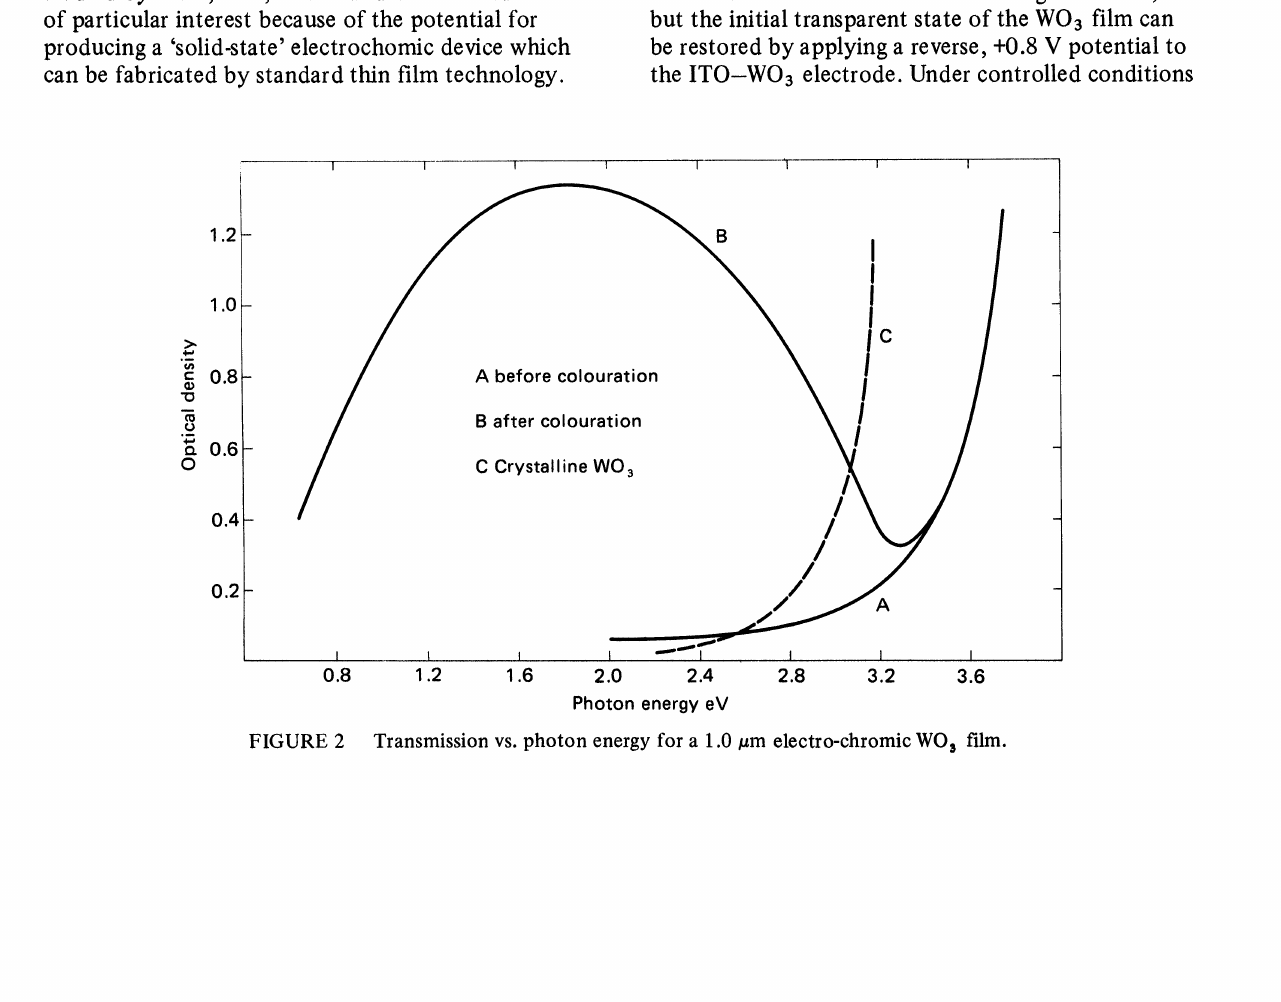
Photon energy eV Transmission vs. photon energy for a 1.0 #m electro-chromic WO